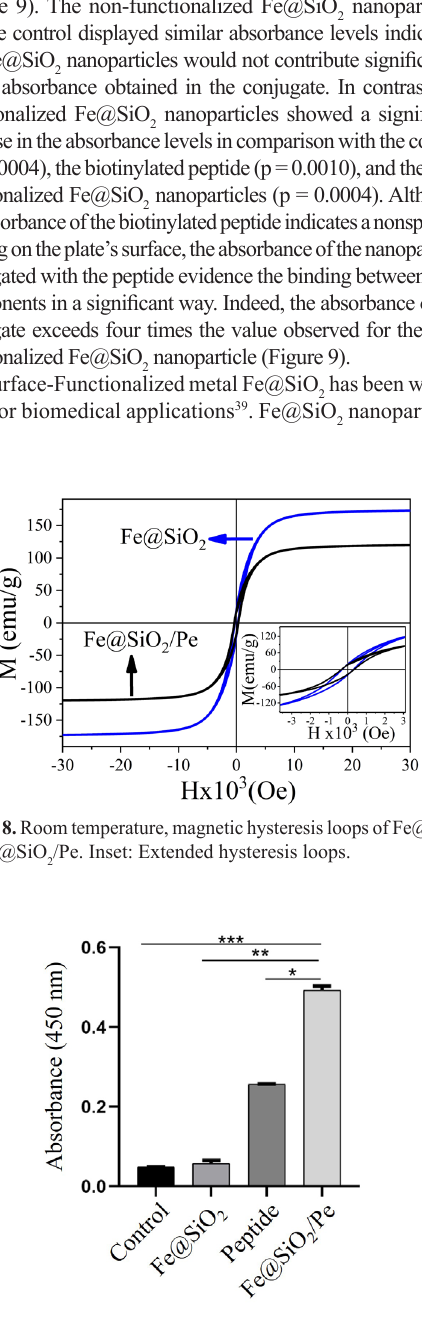
nanoparticles 2